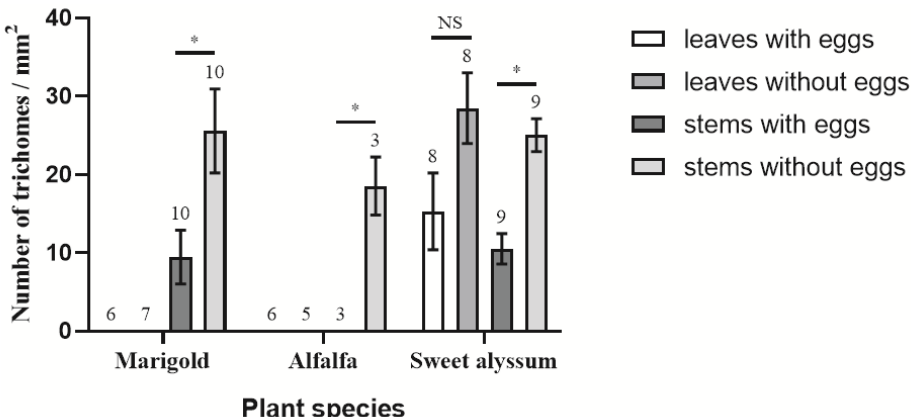
Figure 5. A comparison of the trichome densities on oviposition sites and sites without eggs on the stems and leaves of different plant species. The trichome densities of the same plant tissue with and without Orius sauteri eggs were compared separately for each plant species. * Indicates significant differences ( α = 0.05; t -test) * p < 0.05. Sample sizes for each plant species are indicated above the bars. Values are mean ± SE.